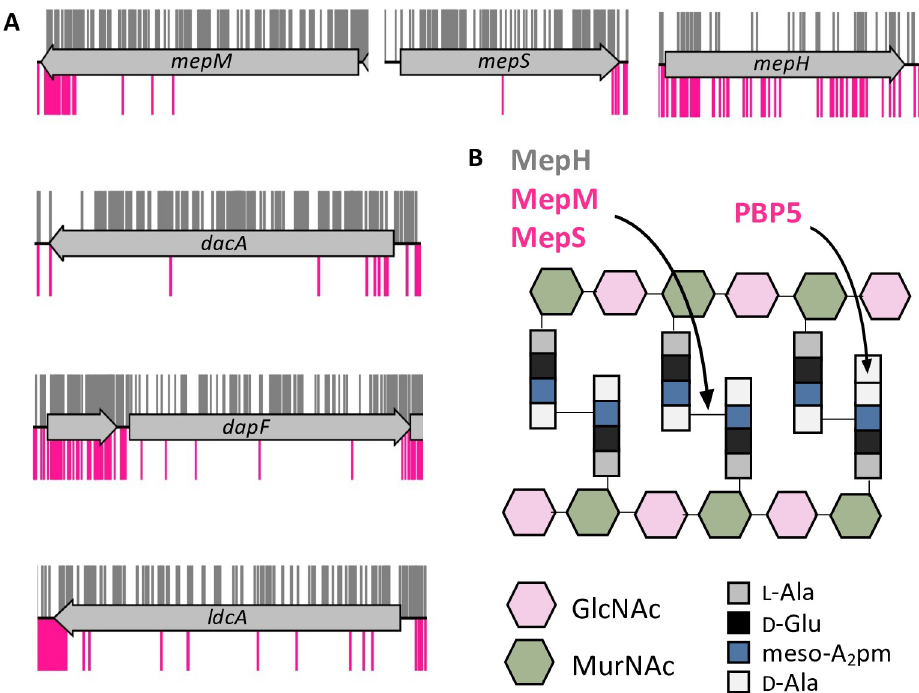
Fig 5. yhcB is synthetically lethal with components of PG synthesis and recycling pathways. (A) TIS data of the BW25113 library (grey) and BW25113 Δ yhcB library (pink) were plotted above and below the gene track, respectively. Insertion sites are represented by vertical bars and are capped at a frequency of 1. (B) Schematic representation of the target sites of the endopeptidases and PBP5 (encoded by dacA ). Abbreviations: meso -diaminopimelate ( meso -A 2 pm); N-acetylglucosamine (GlcNAc); N-acetylmuramic acid (MurNAc); L-alanine (L-ala); D-glutamic acid (D-Glu); D- alanine